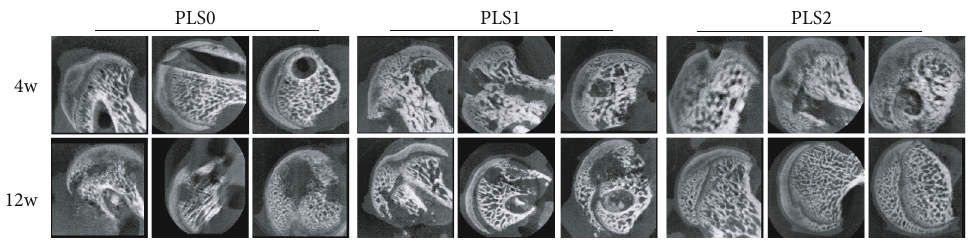
Figure 2: Representative coronal, transverse and sagittal micro-CT scans of the di ff erent treatment groups.